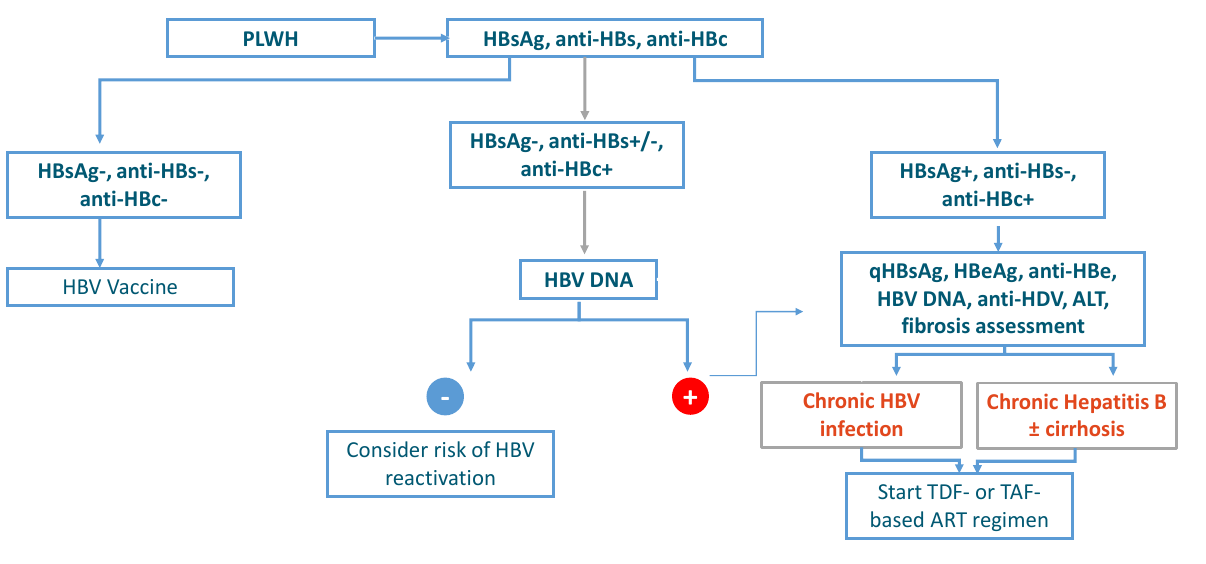
Figure 1. Algorithm for the management of HBV infection in PLWH.